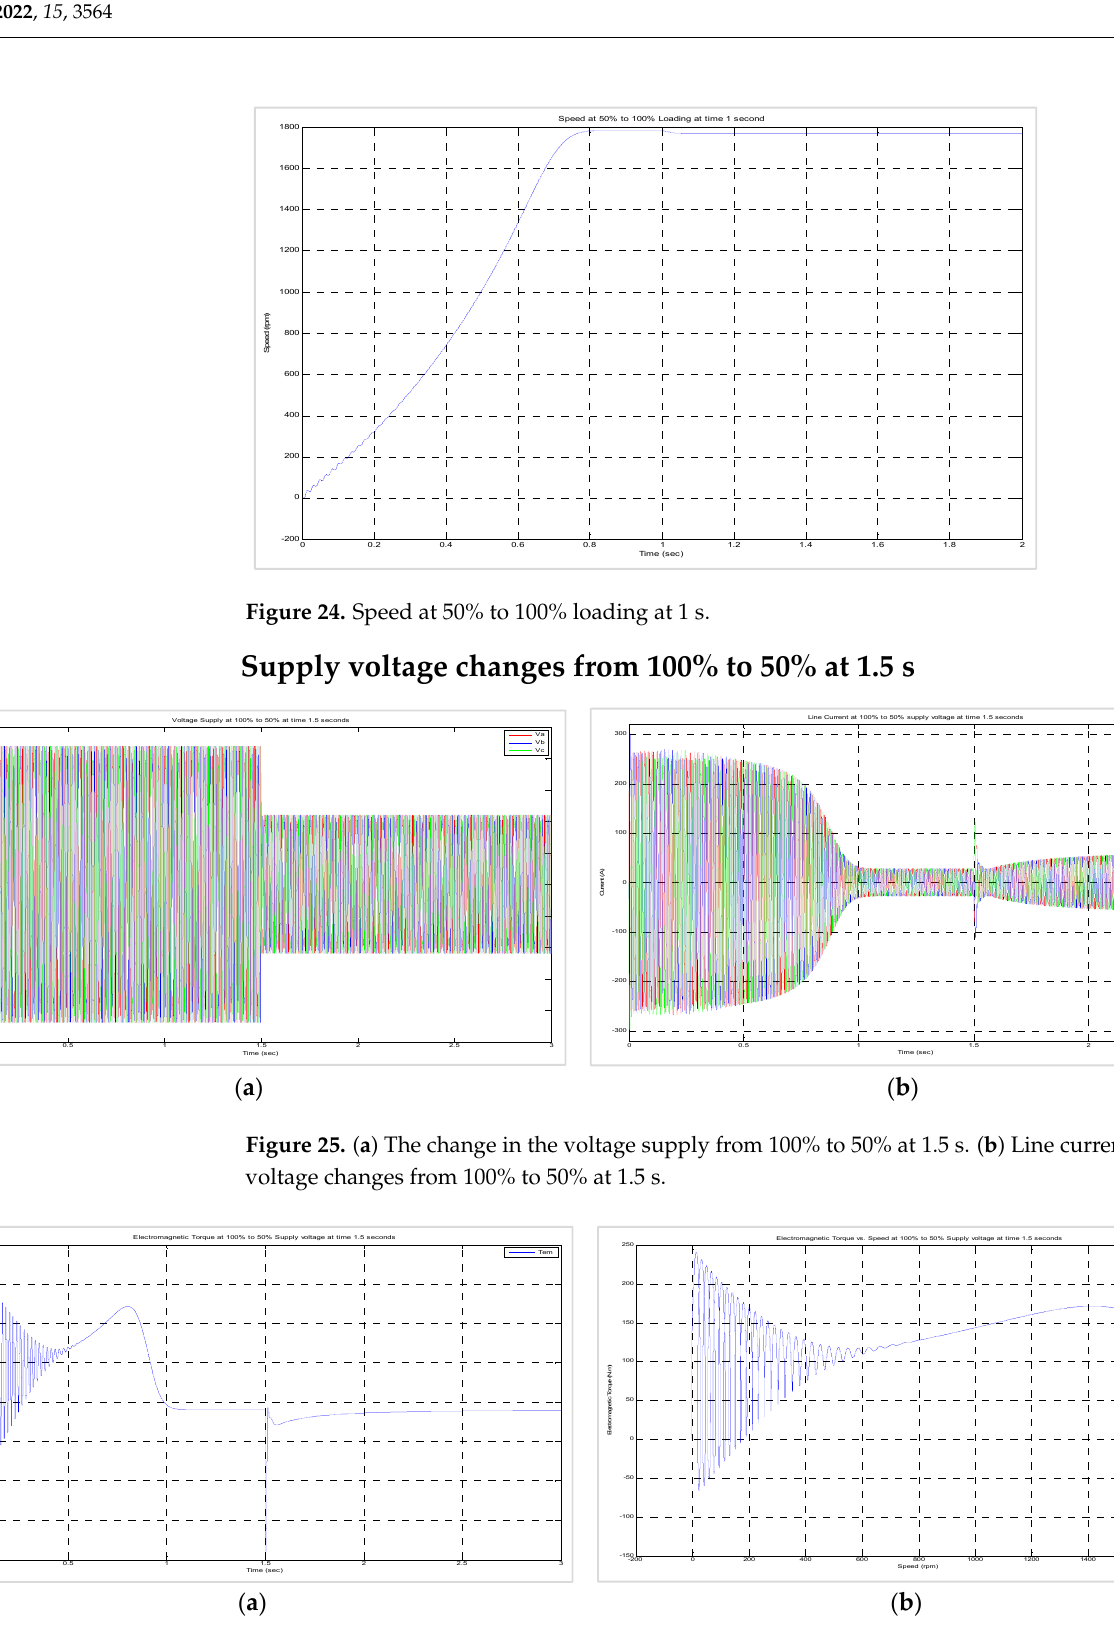
Figure 26. ( a ) Electromagnetic torque when the supply voltage changes from 100% to 50% at 1.5 s. ( b ) Electromagnetic torque vs speed when the supply voltage changes from 100% to 50% at 1.5 s. As seen in Figure 27, the speed decreases due to the supply voltage being halved at 1.5 s; thus, the electromagnetic torque is less than the loading torque. This means that the machine is not able to operate under these specific conditions.